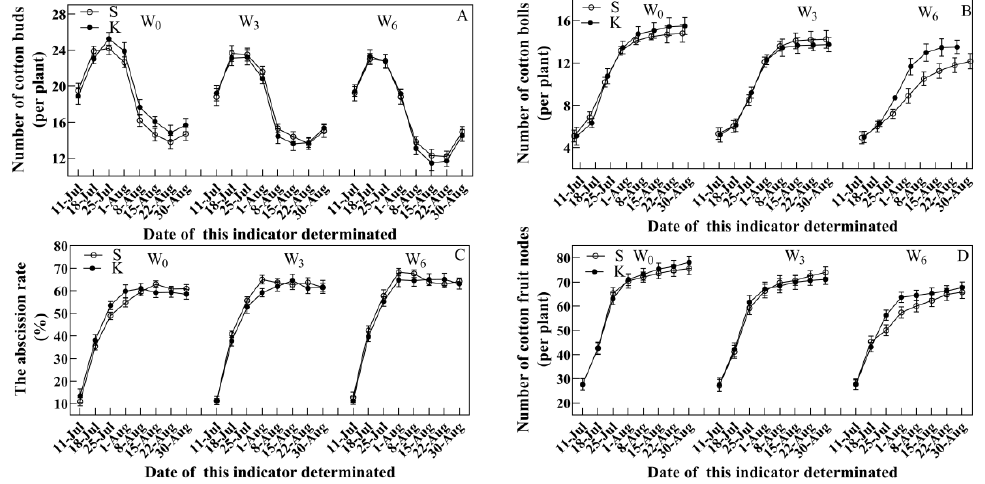
Figure 3. Effect of potassium application on agronomic traits (( A ) number of cotton buds; ( B ) number of cotton bolls; ( C ) the abscission rate; ( D ) number of cotton fruit nodes) in cotton under soil waterlogging stress. S represents the soil waterlogging without potassium treatment groups. K represents the soil waterlogging with potassium treatment groups. W0, W3 and W6 represent 0 d, 3 d and 6 d soil waterlogging treatment, respectively.